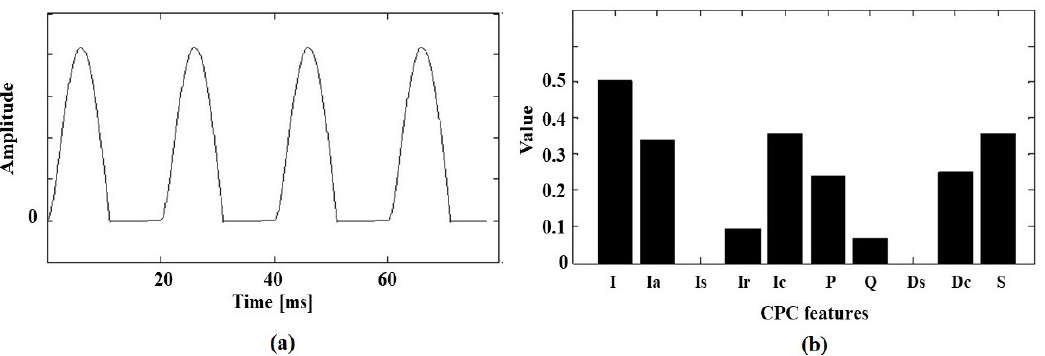
Figure 7. Diode: ( a ) Simulated current waveform; and ( b ) CPC features.